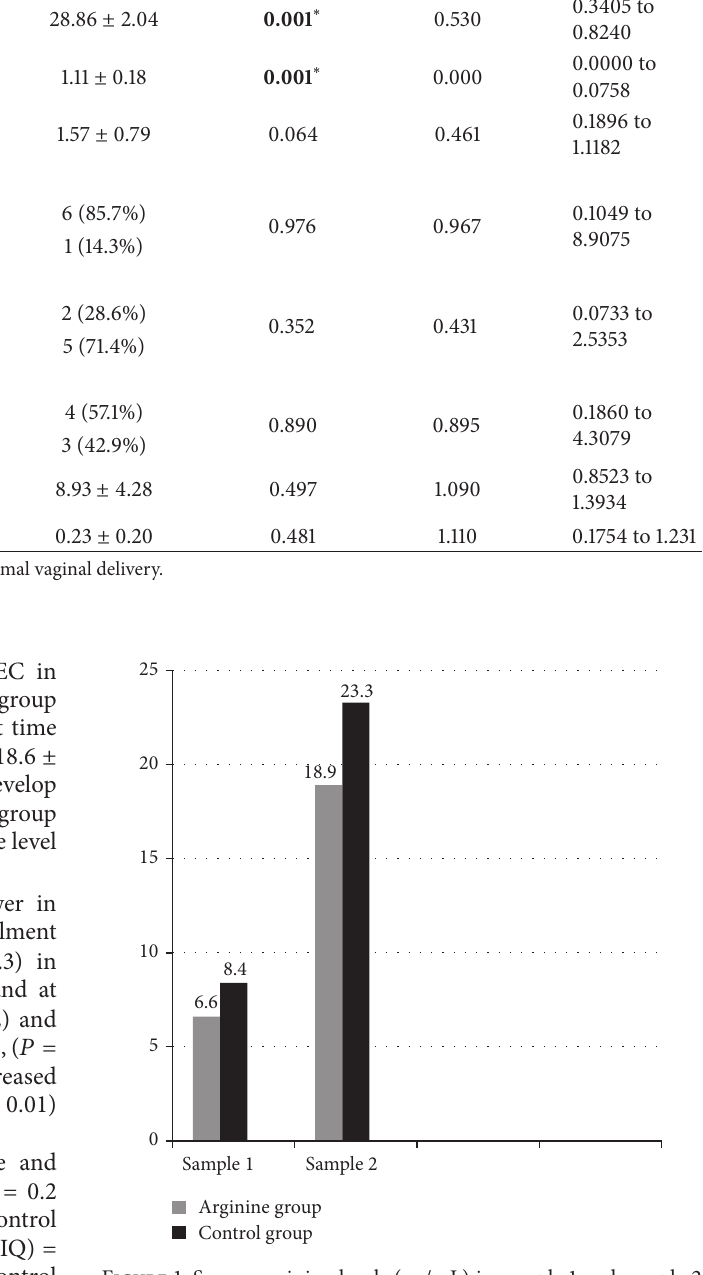
Figure 1: Serum arginine levels (ng/mL) in sample 1 and sample 2 in L-arginine and control